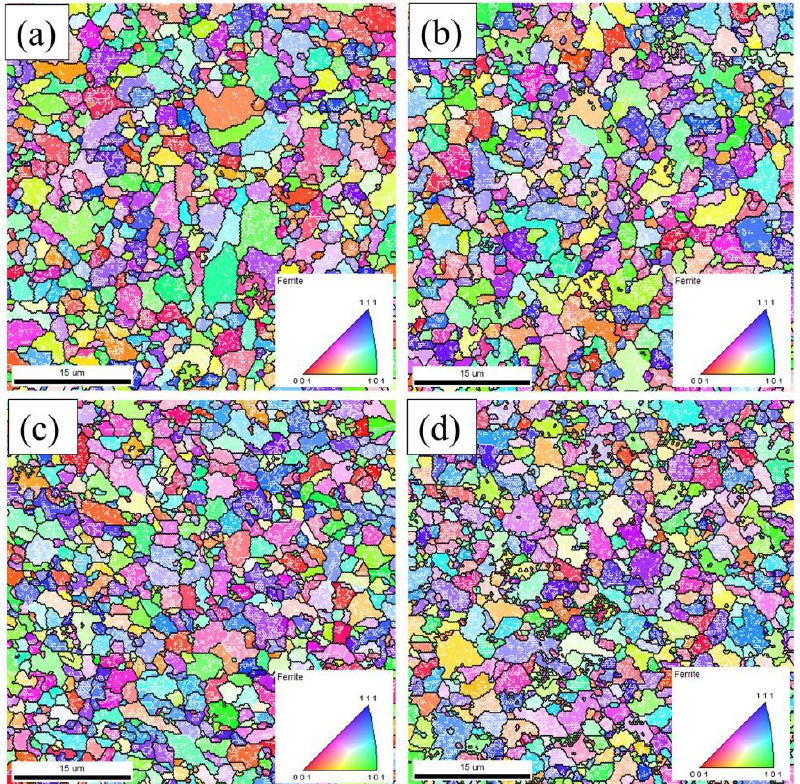
Figure 1. EBSD mapping of grain orientations and grain boundaries of FeCrAl ODS steels with different Zr contents: ( a ) 0 wt.%, ( b ) 0.3 wt.%, ( c ) MEDIA CYBERNETICS 0.6 wt.%, ( d ) 1.2 wt.%.